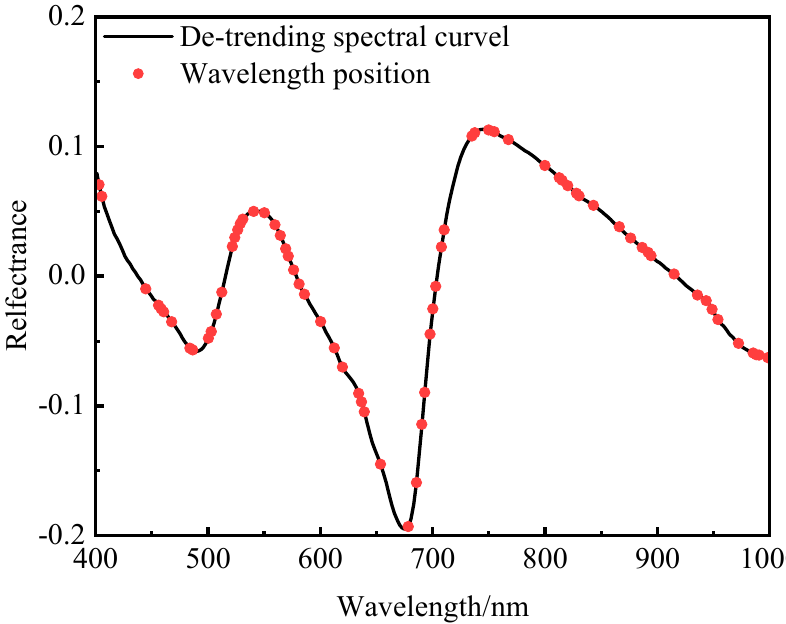
Figure 6. Characteristic wavelengths of the de-trending spectral curve selected using the PSO al- gorithm.